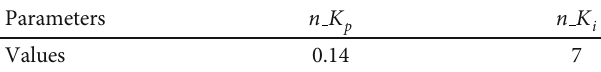
Table 4: PI parameters of LO